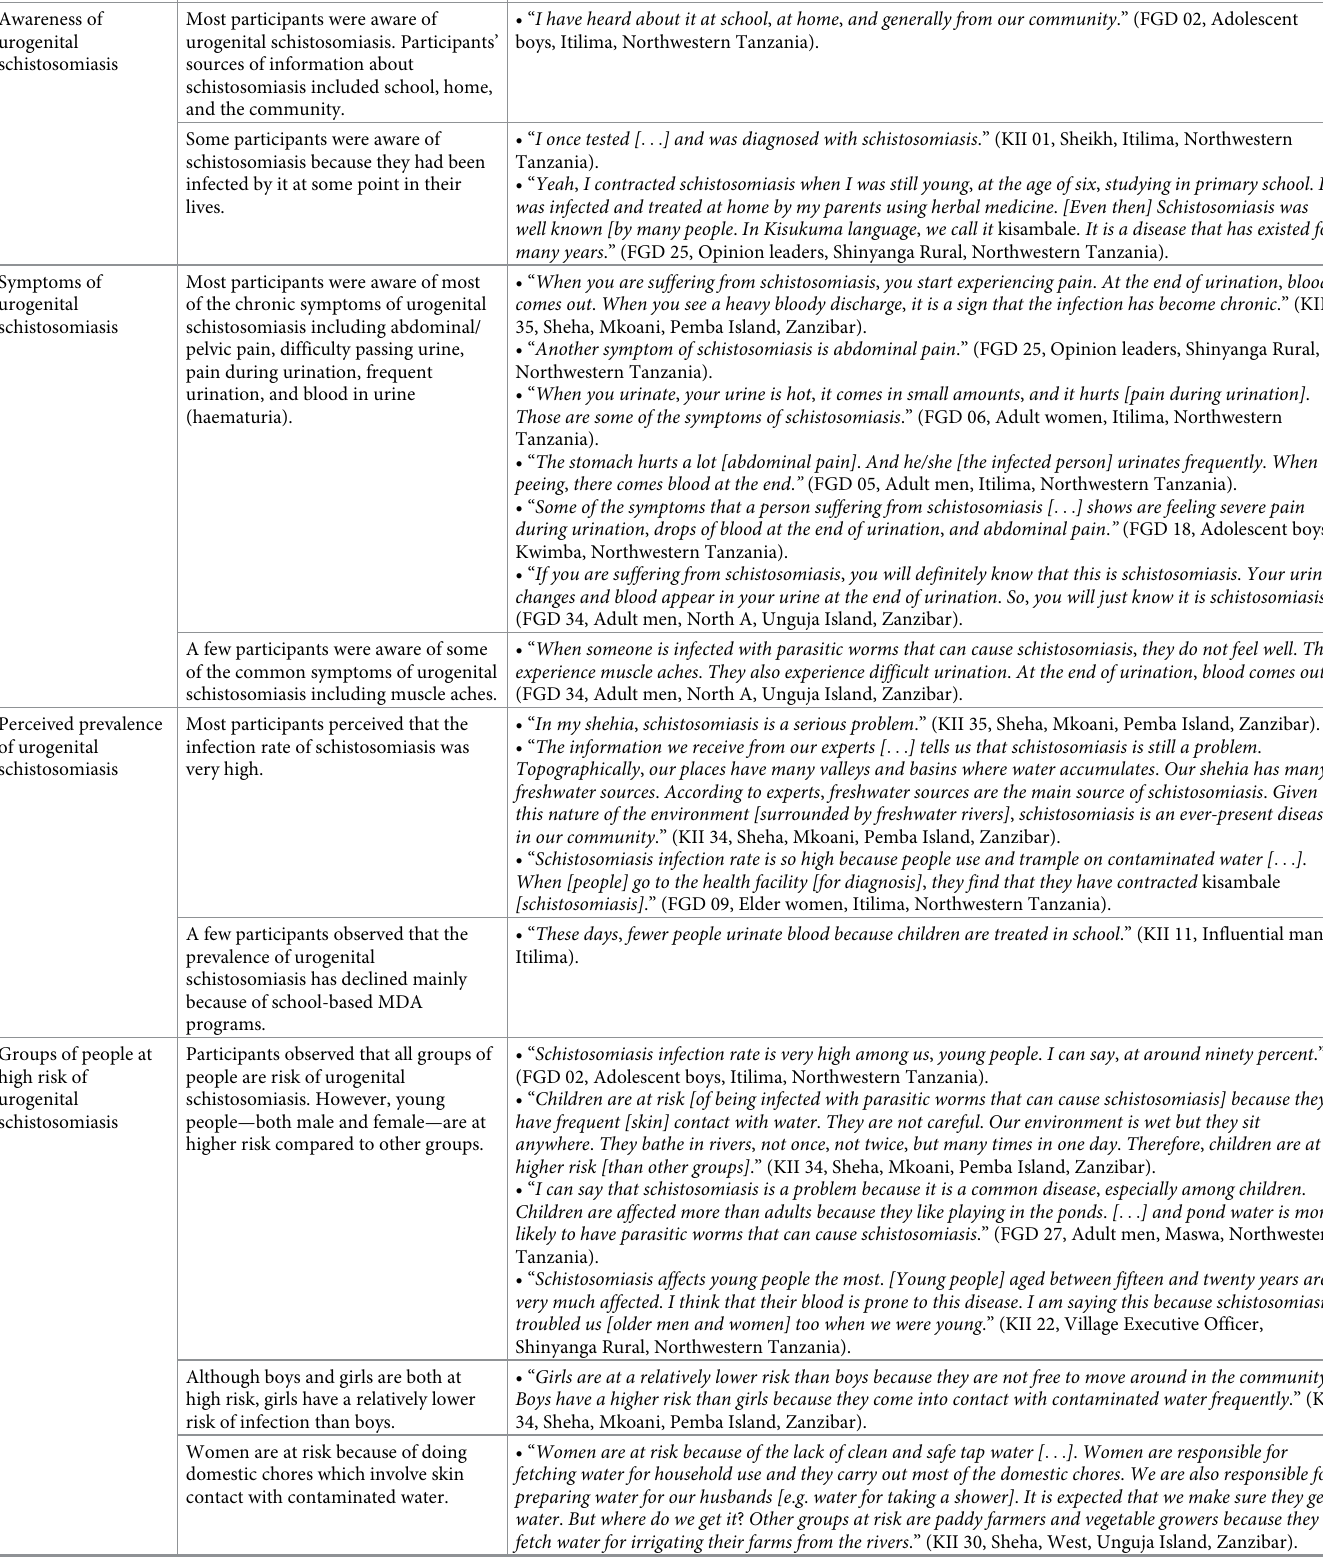
Table 4. Community members’ knowledge and perceptions about urogenital schistosomiasis in Northwestern Tanzania and